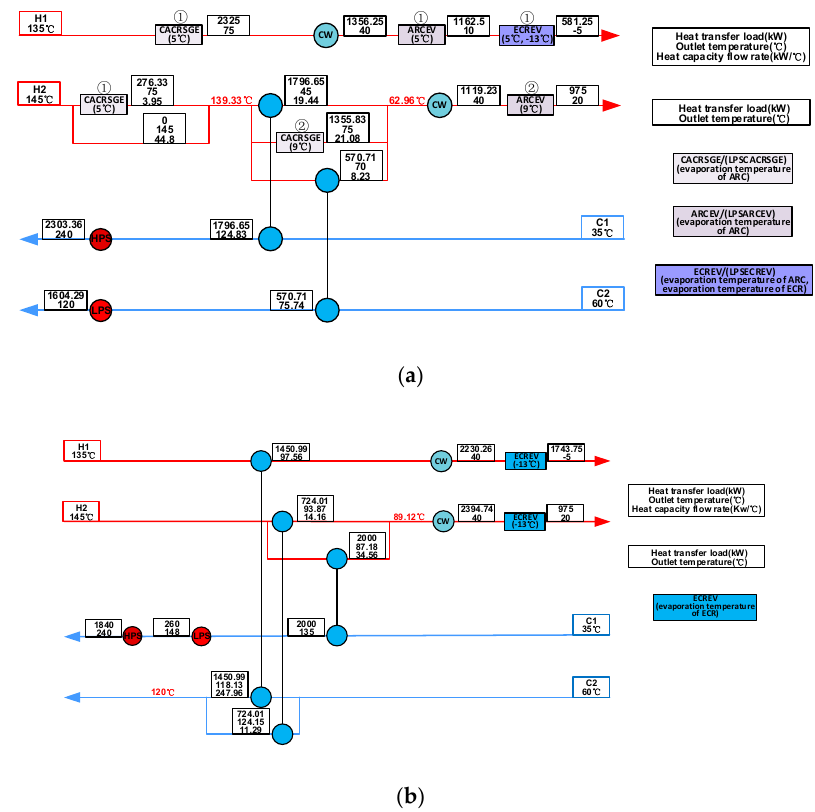
Figure 4. Result of case 1. ( a ) Structure of the integrated HEN with CACRS; ( b ) Structure of the integrated HEN with ECR.